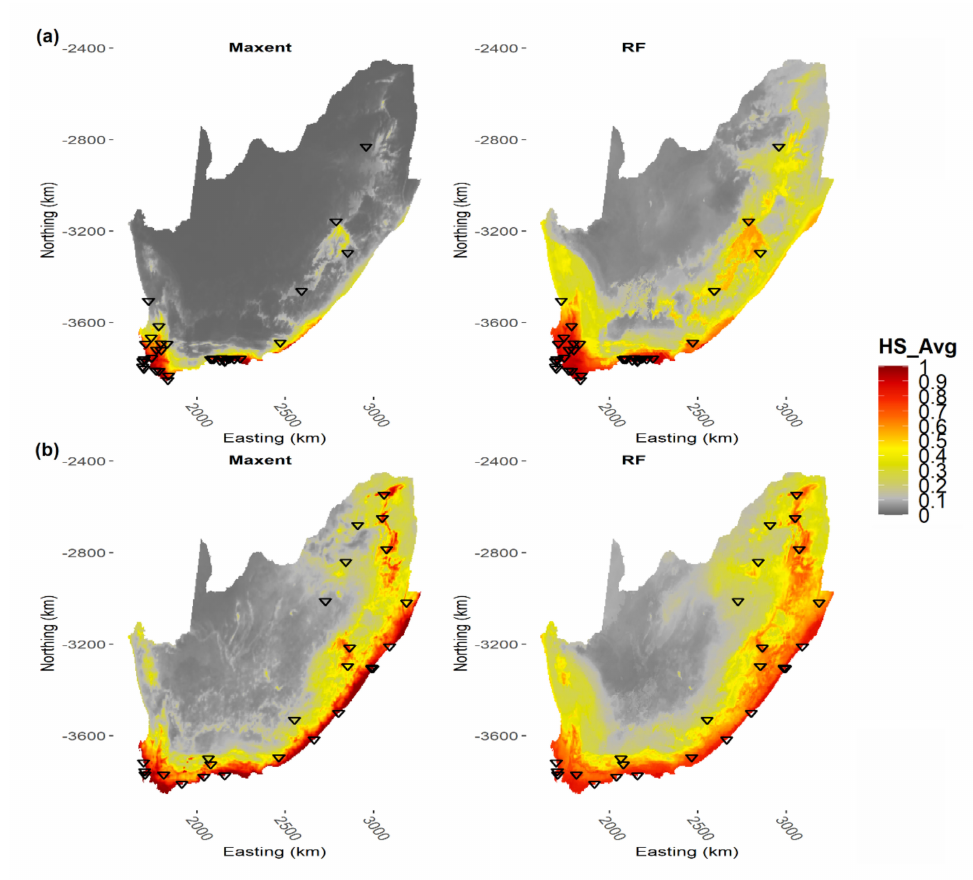
Figure 5. Weighted average predicted habitat suitability (HS_Avg) across the study region resulting from the tuned Maxent and Random Forests (RF) models for: ( a ) Chaetocnema darwini ; ( b ) C. natalensis . Reversed black-contoured triangles indicate the species’ occurrence